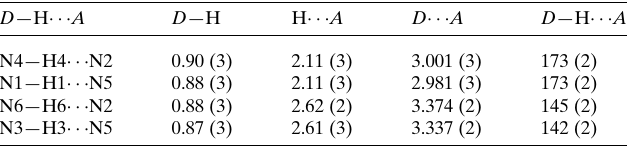
Table 1 Hydrogen-bond geometry (A˚ , (cid:4)